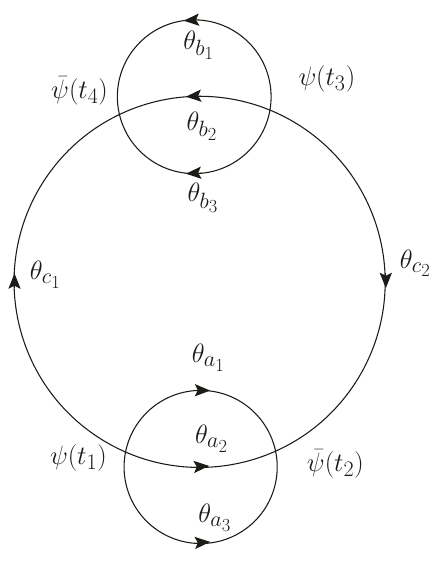
Figure 5 . Direction of arrow is from to (cid:22) . The diagram is drawn for q =